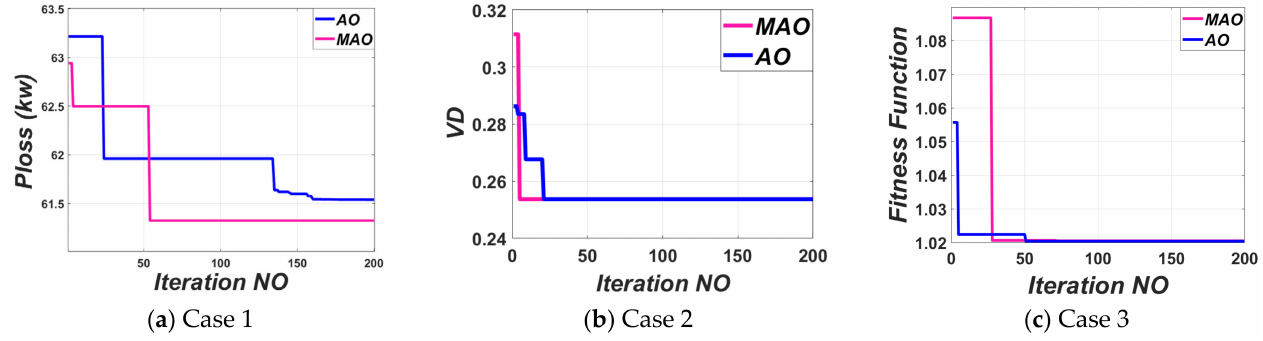
Figure 16. Convergence curve of the IEEE 33-bus system.